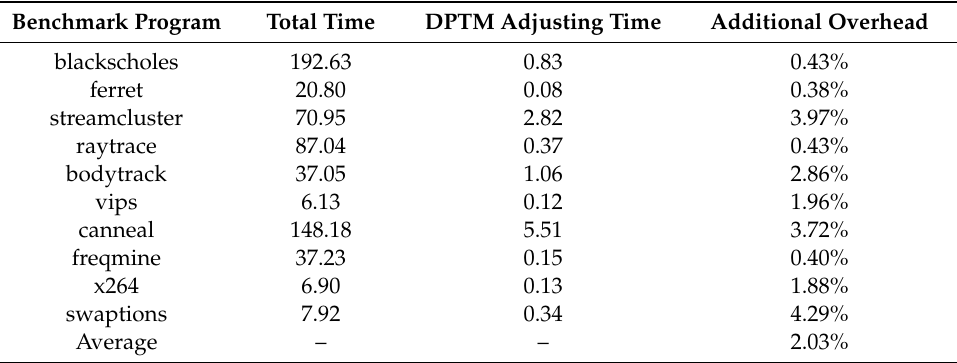
Table 2. The overhead of DPTM on 10 benchmark programs.